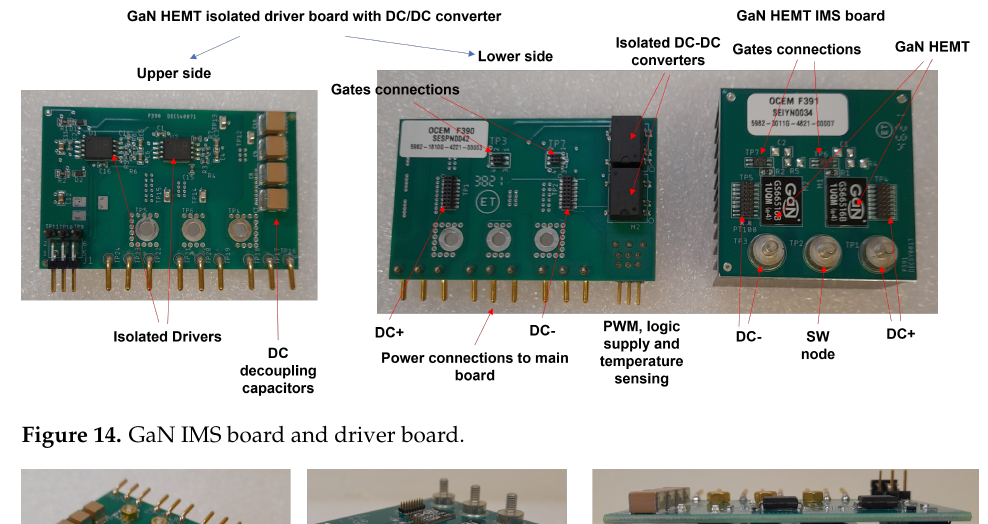
Figure 13. Simplified schematic of the entire converter.